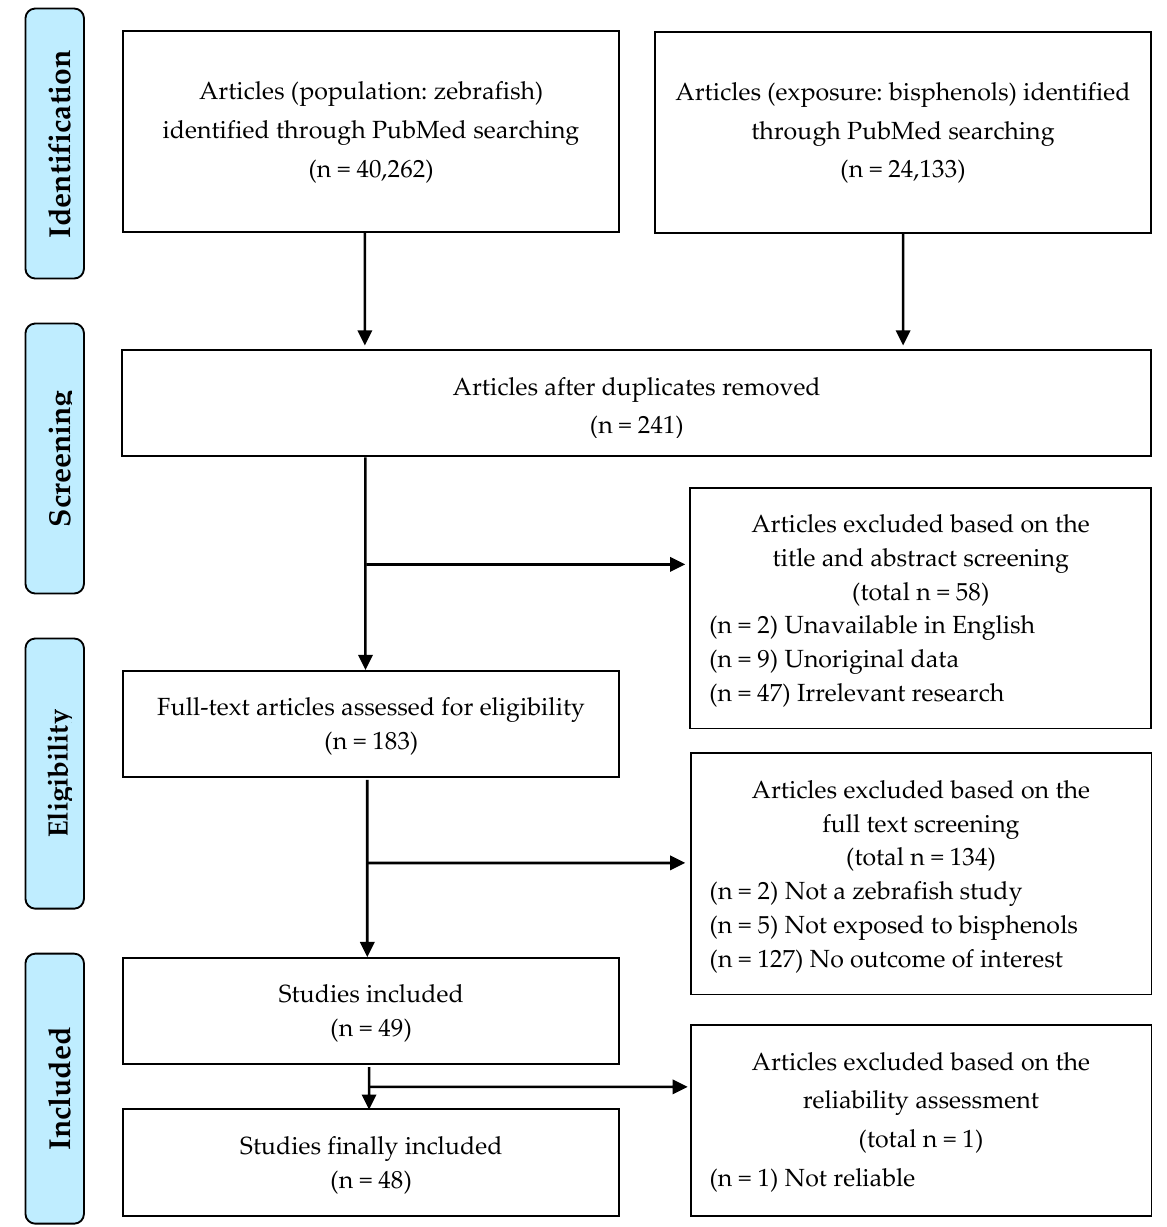
Figure 1. Flow chart of study selection process.